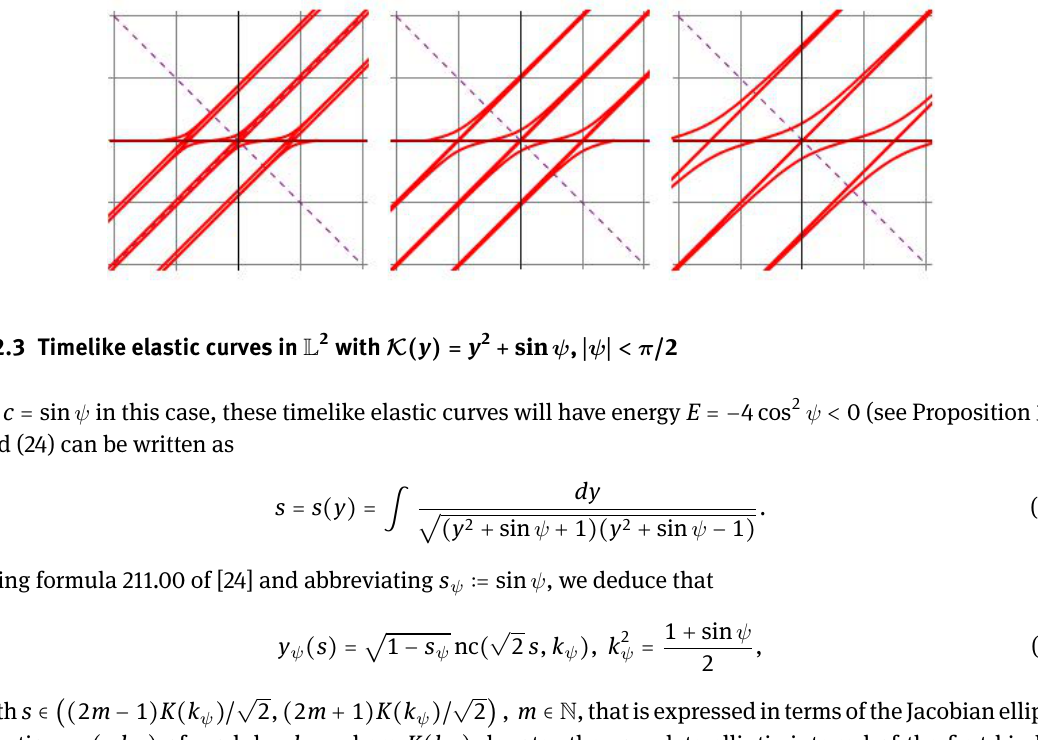
Fig. 8. Timelike elastic curves β δ ( δ = 0.5,1,1.5 ).